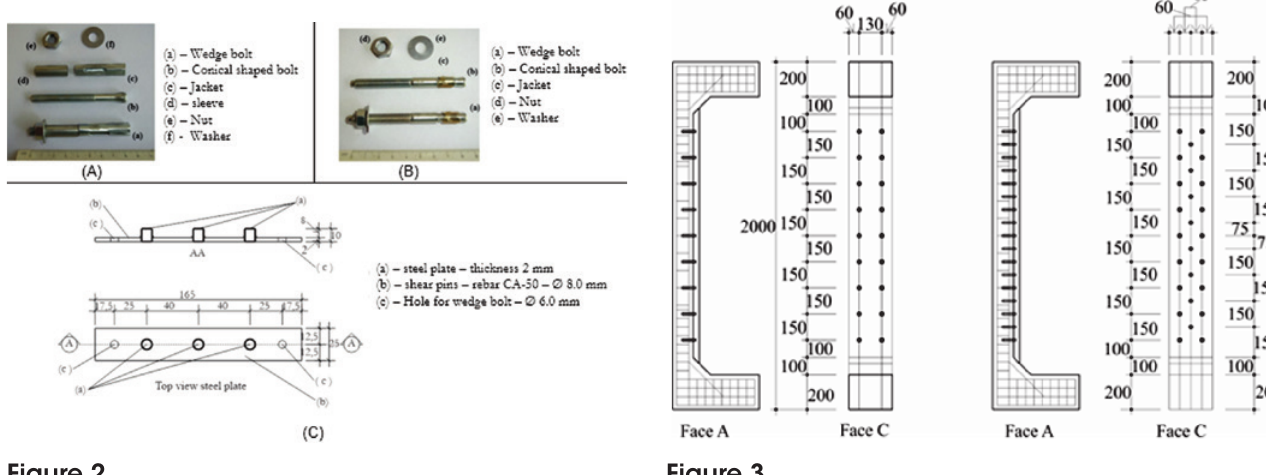
and PAF-150-26 (dimensions in